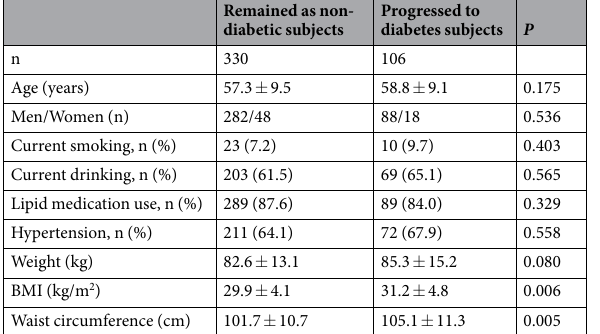
Table 1. Baseline demographics and anthropometrics characteristics of the study subjects by glycaemic status at the end of the follow-up period. Data are presented as mean ± SD for continuous variables or n (%) for categorical